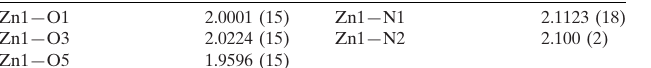
Selected bond lengths (A˚ ).